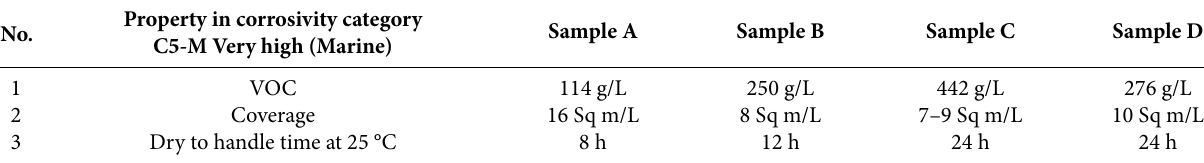
Table 5. Comparison of some properties of the improved polyaspartic coating and conventional anti-corrosive coating systems. Property in corrosivity No.